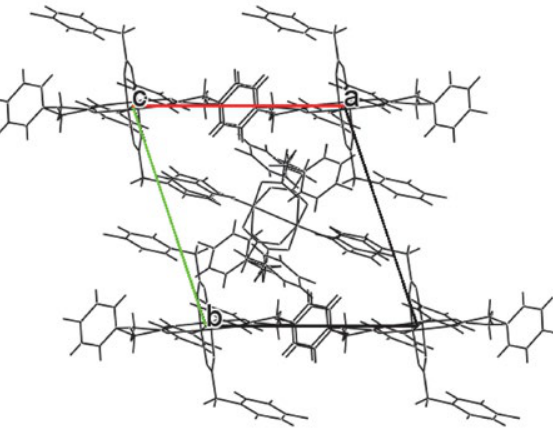
Fig. 3. Packing diagram of the complex along c